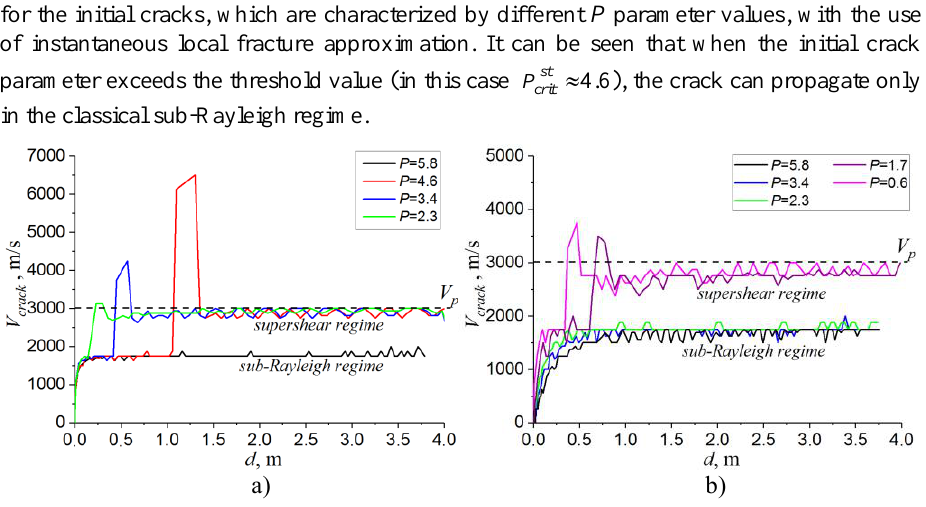
Fig. 3 . The crack tip propagation velocity V crack dependences on the crack tip path length d for samples with different initial crack lengths: a) infinitely small fracture incubation time; b) finite fracture incubation time (criterion